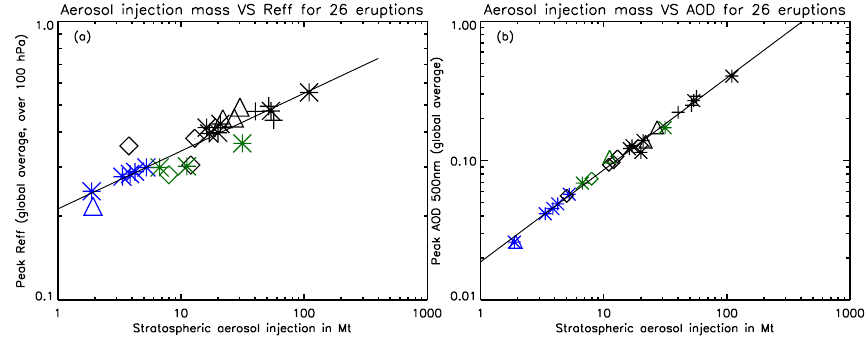
Fig. 1. Total mass of aerosol (H 2 SO 4 +H 2 O) in Mt versus (a) calculated peak of effective radius by the AER model for each of the 26 modeled eruptions over the 1600–2000 period (effective radius values are global mean average above 100hPa, and (b) peak AOD at 550nm. Black line shows the logarithmic fit for the tropical eruptions. Stars indicate spring eruptions, triangles summer eruptions, diamonds fall eruptions and crosses winter eruptions. Black color indicates tropical eruptions, while blue and green colors indicate extratropical eruptions in the Southern and Northern Hemispheres,